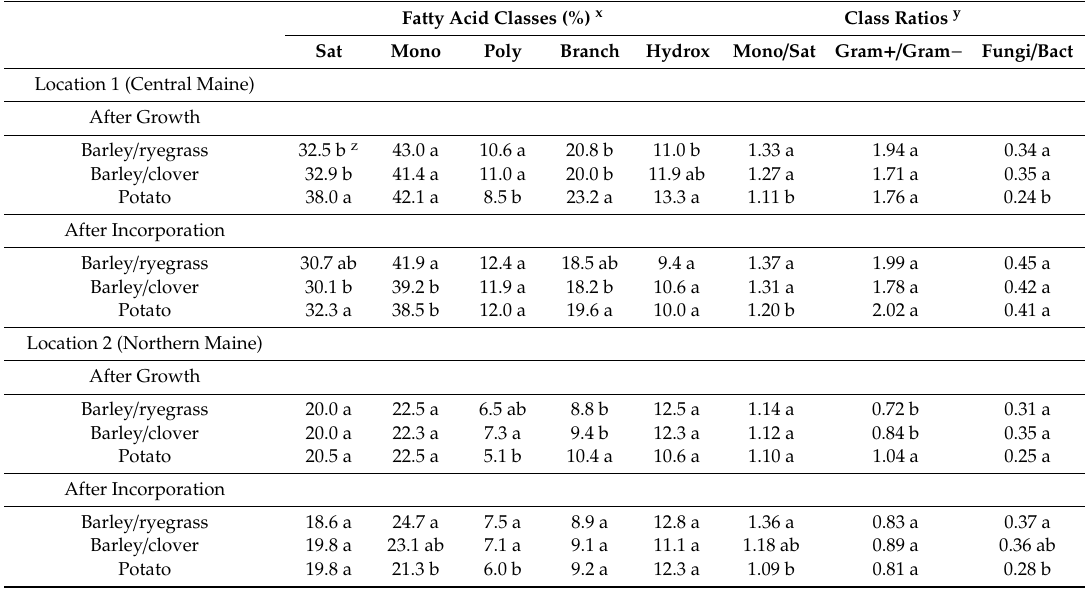
Table 5. E ff ect of rotation crops both prior to and after residue incorporation in Spring year 2 on di ff erent fatty acid structural classes and class ratios.